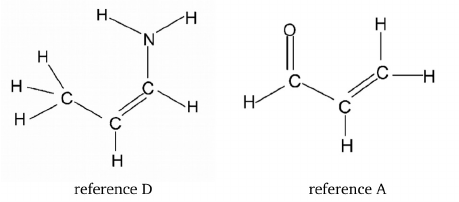
Figure 18. Two reference molecules used in RBM for 3-aminoacrolein